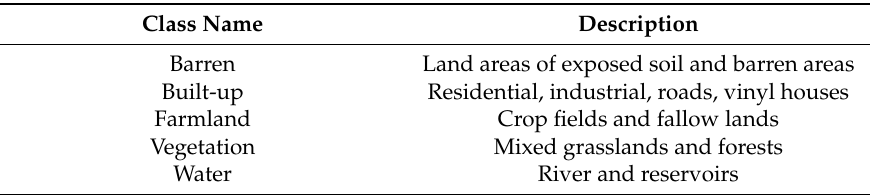
Table 2. Land cover classes classified in the